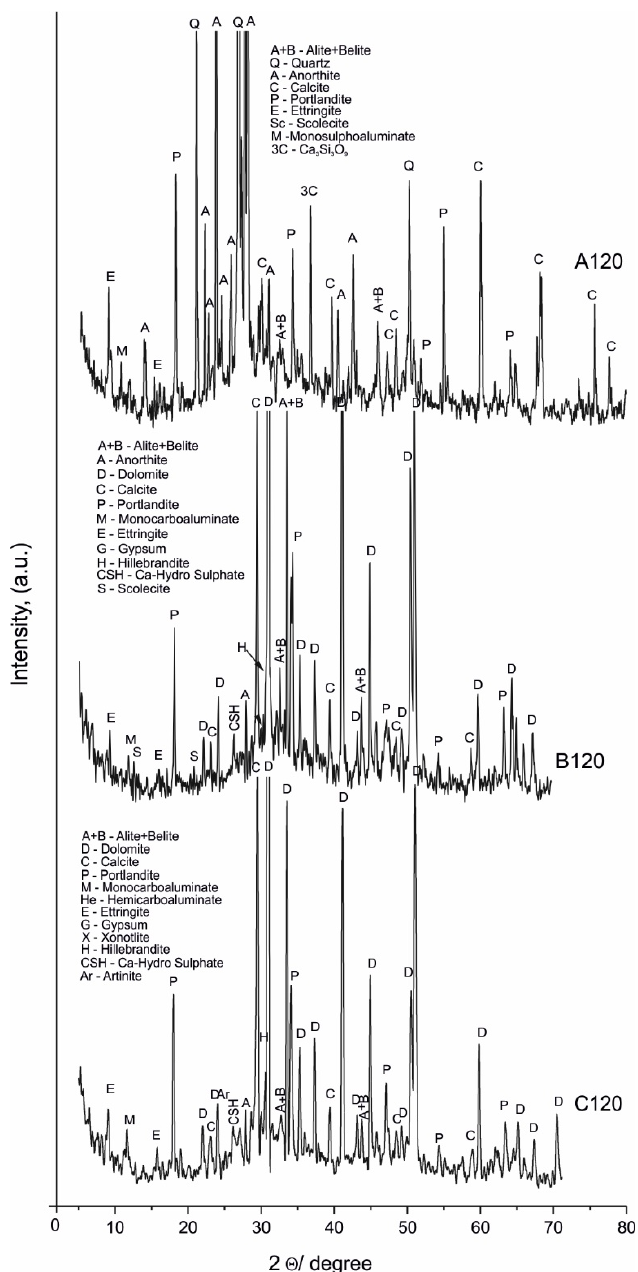
Figure 3. PXRD patterns of A120, B120, and C120. Table 3. Results from PXRD analysis of raw materials (white Portland cement, marble powder, and sand) and A028, A120, B028, B120, C028, and C120.